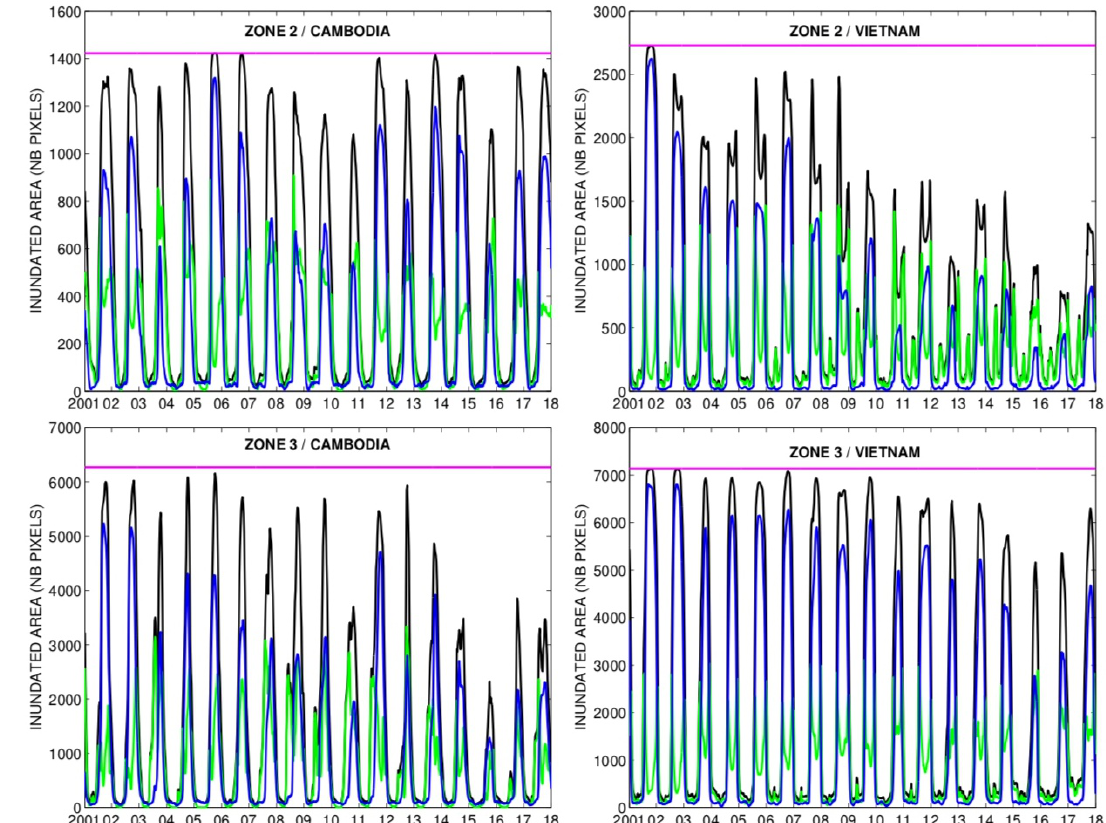
Figure 4. Time series of the total = mixed + water (black), mixed (green), and water (blue) areas (in number of pixels) over the six zones of Figure 1 over Cambodia ( left ) and Vietnam ( right ), from 2001 to 2017. The total number of pixels in each zone is also indicated in magenta, it represents the maximum flooding area for each zone. Each pixel is about 500 m × 500 m = 0.25 km 2